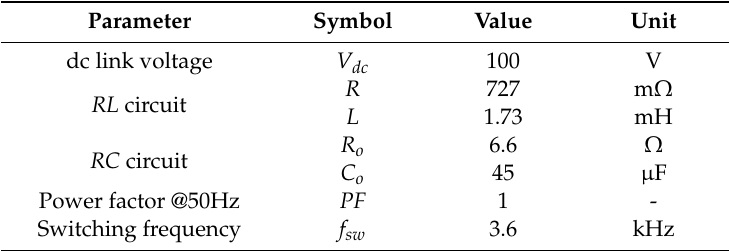
Table 2. Experimental setup circuital parameters.